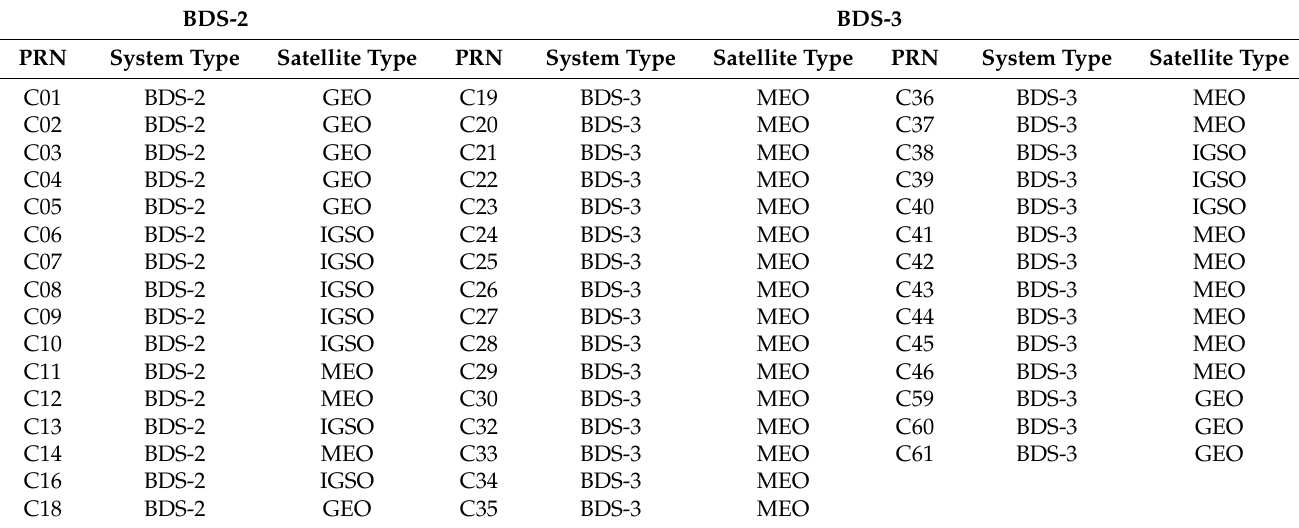
Table 2. BDS satellite types (July